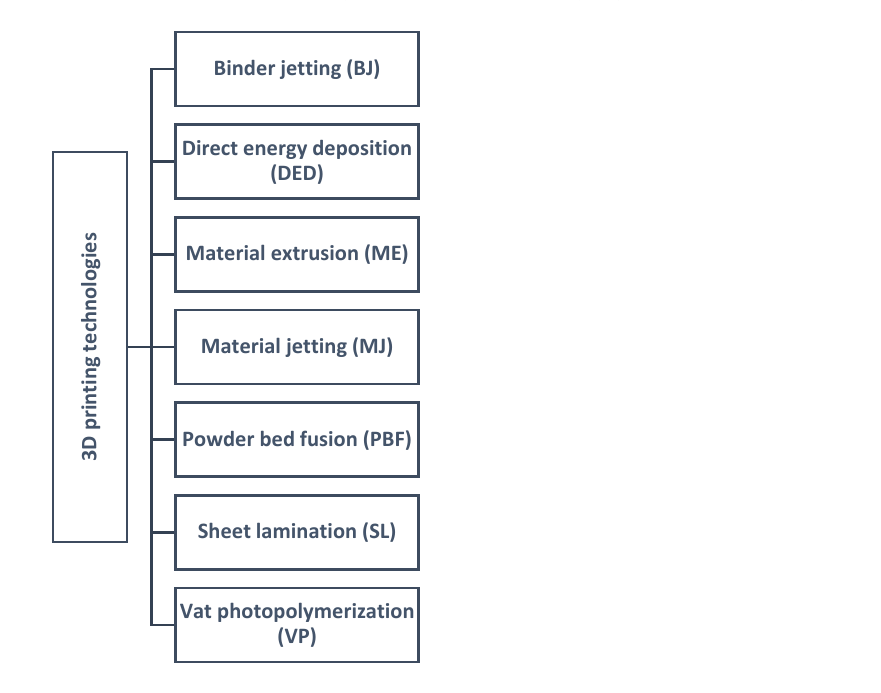
Figure 1. Schematic diagram of the seven different 3D printing technologies according to the ASTM F2792 standard.